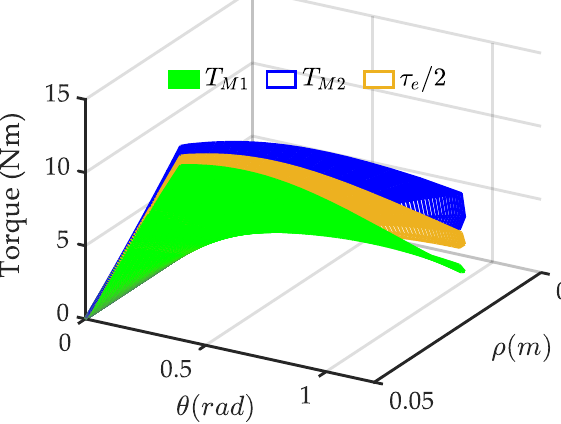
Figure 11. The load distribution observed in ADAMS.